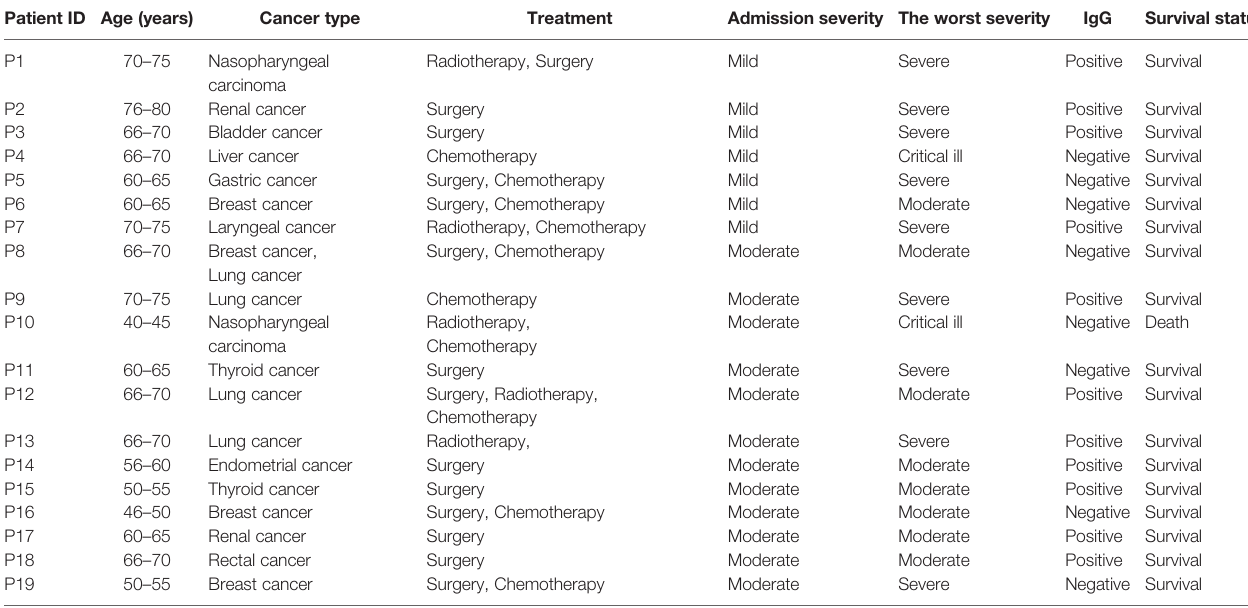
TABLE 2 | The basic information of patients with cancers and COVID-19. Patient ID Age (years)